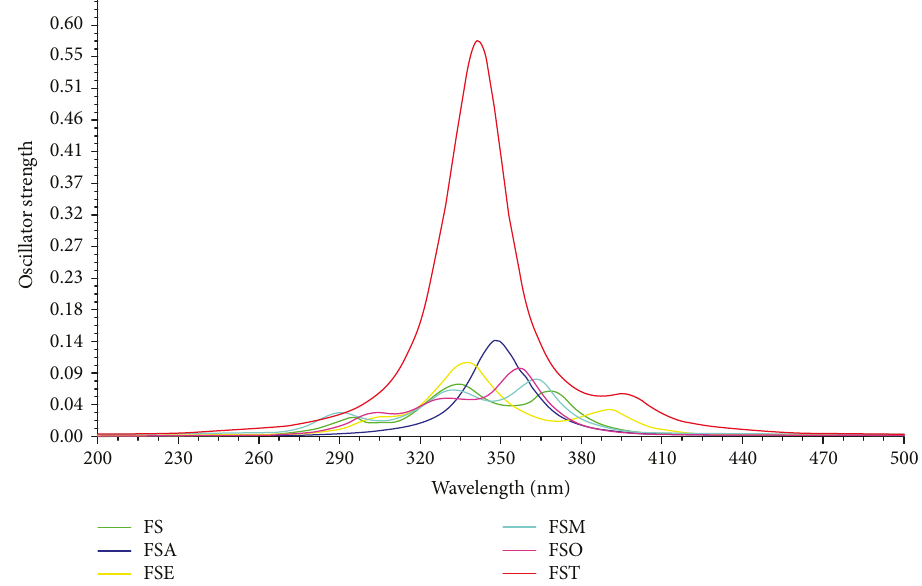
Figure 5: The maximum wavelength and oscillator strength of all fl uorescein dye derivatives in the solvent